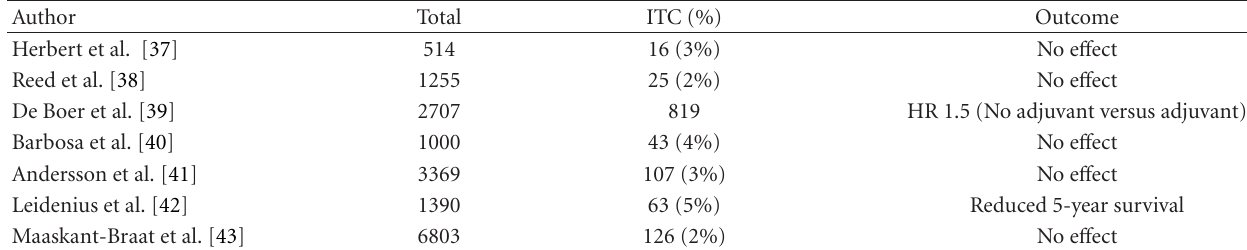
Table 2: Incidence and prognostic impact of ITCs in sentinel node